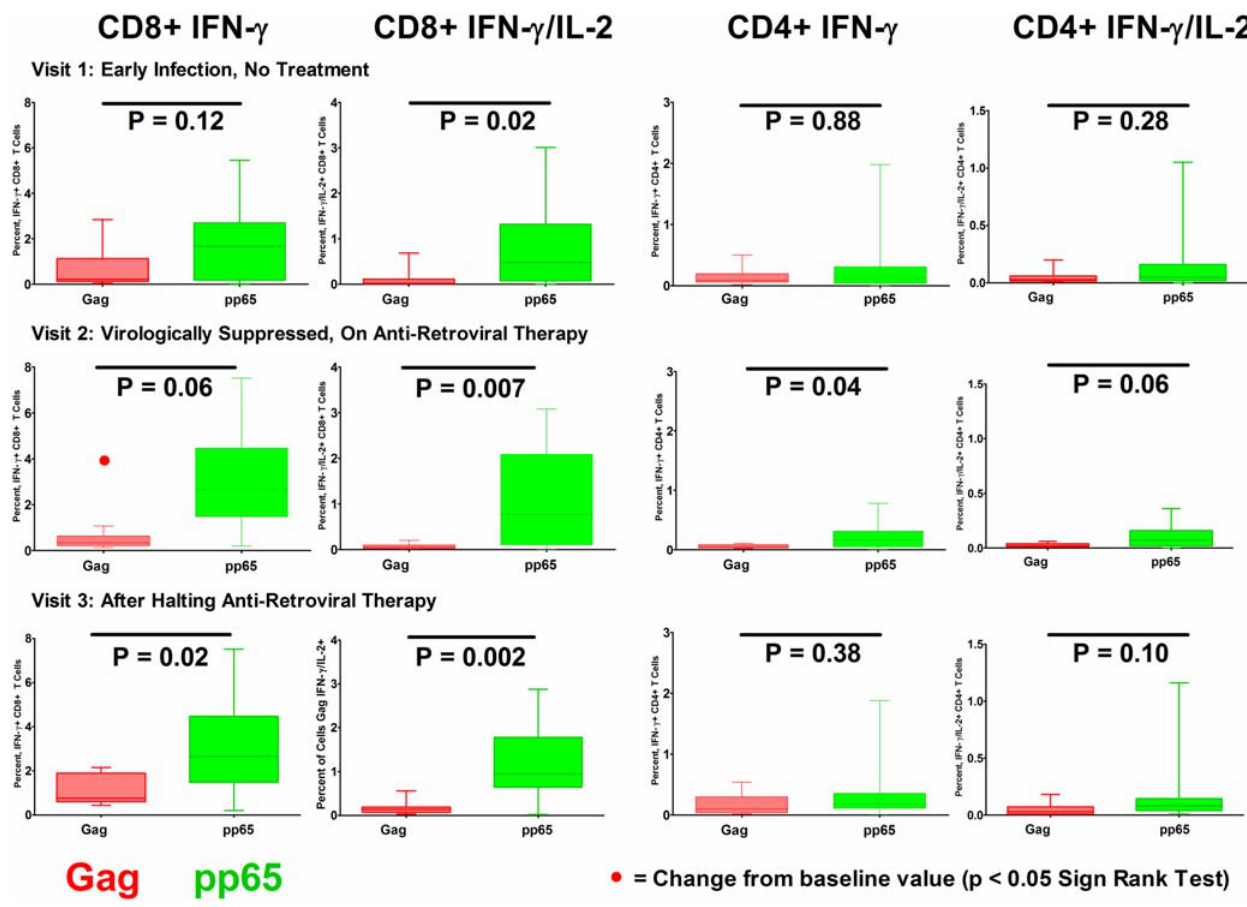
Figure 2. Magnitude of CD4 + and CD8 + T Cell Responses to HIV-1 Gag and CMV pp65. at each of the three study visits. Proportion of IFN- c + and IFN- c + IL-2 + CD8 + (columns 1 and 2) and CD4 + (columns 3 and 4) T cells, responding to stimulation with Gag and pp65 peptide pools. Results for visit 1, prior to antiretroviral therapy visit 2, during a virologically suppressive anti-retroviral regimen, and visit 3, after patients had halted an anti-retroviral regimen and viremia had rebounded are shown in upper, middle and lower rows respectively. Black bars indicate differences between HIV-1 Gag and CMV pp65 responses by response category (Wilcoxon 2 Sample Test). Red dot (1 st column, 2 nd row) notes a significant change from baseline (visit 1) values (Sign Rank Test). Only the CD8 + T cell IFN- c response to Gag was observed to significantly change (in this case decline) from visit 1 to either visit 2 or visit 3.